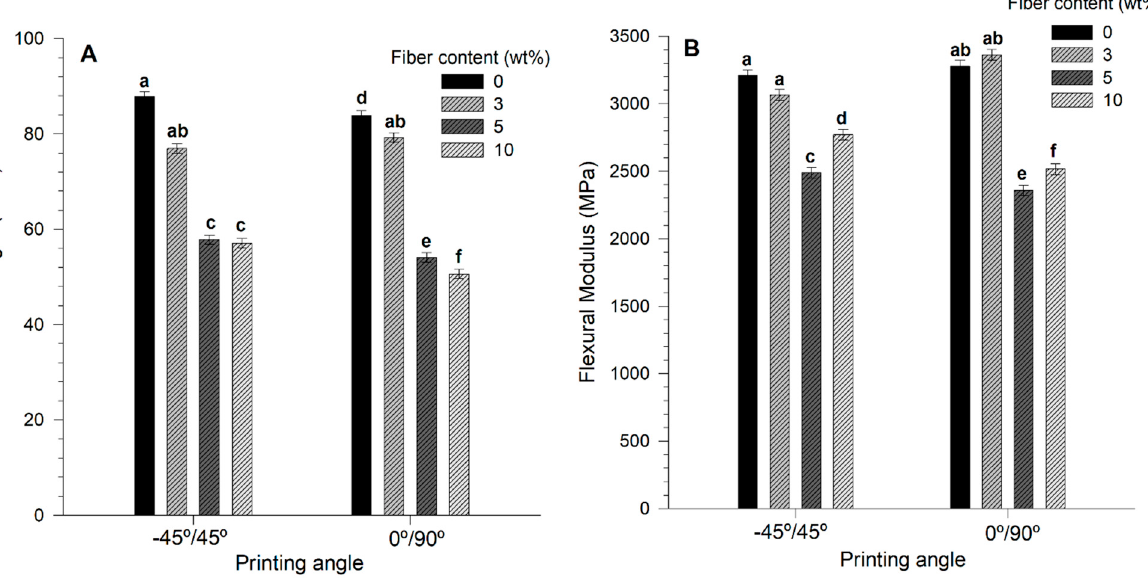
Figure 5. ( A ) Flexural strength and ( B ) flexural modulus of printed agave fibers/PLA biocomposites. The letters a–f on top of the bars indicates significant differences ( p < 0.05).